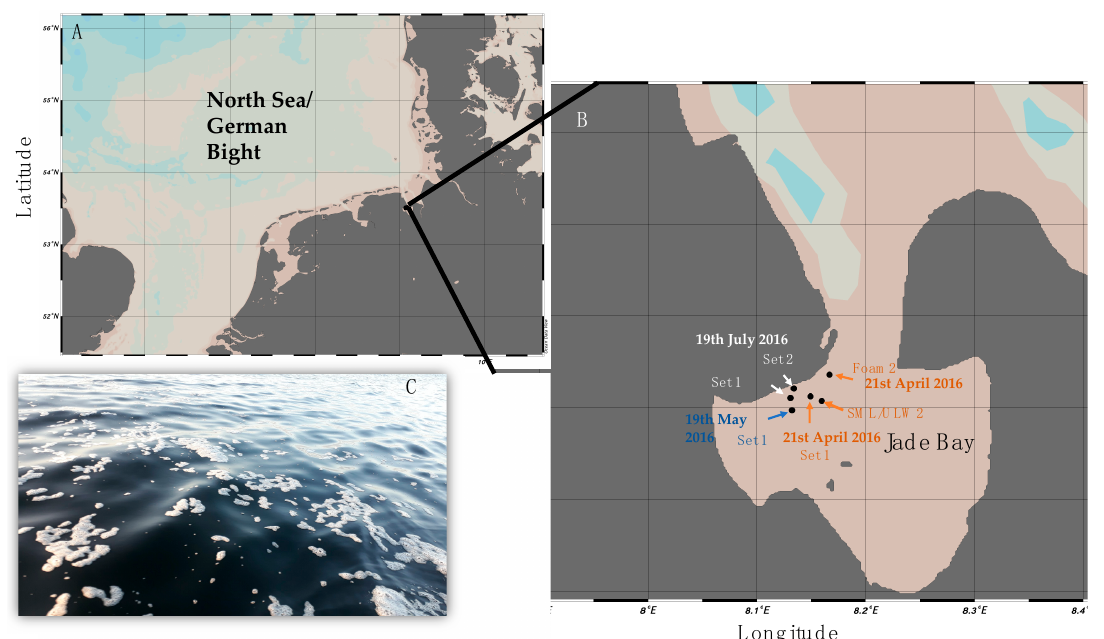
Figure 1. ( A ) Sampling stations in the Jade Bay, North Sea/German Bight, Germany; ( B ) A whole sampling set refers to foam/sea-surface microlayer (SML)/1-m depth = underlying water (ULW). As indicated, on one occasion foam and SML/ULW were collected in different places. Coordinates for Set 2 from 19 th May 2016 are missing. ( C ) The occurrence of patchy sea foam floating at the sea surface (Photo: Janina Rahlff). Map was generated using Ocean Data View [36].